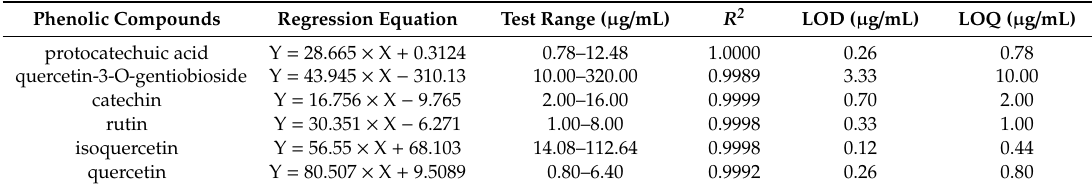
Table 4. Linear regression data for the six investigated phenolic